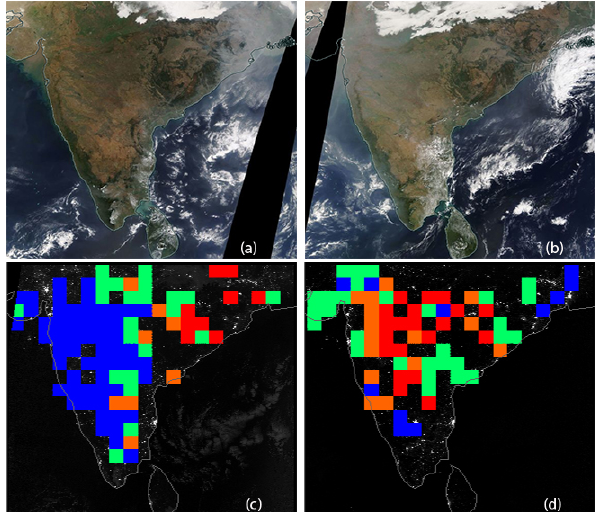
Figure 10. Terra MODIS true color imagery (NASA Worldview) for 12 January 2015 over India. Panel (b) is similar to (a) but for 16 January 2015. (c) VIIRS nighttime imagery on 12 January 2015. Overplotted are VIIRS nighttime AOT retrievals in 1 ◦ × 1 ◦ (latitude by longitude) grid format. Blue, green, orange and red represent AOT ranges of 0–0.2, 0.2–0.4, 0.4–0.6 and >0.6, respectively. Panel (d) is similar to (c) but for 16 January 2015.